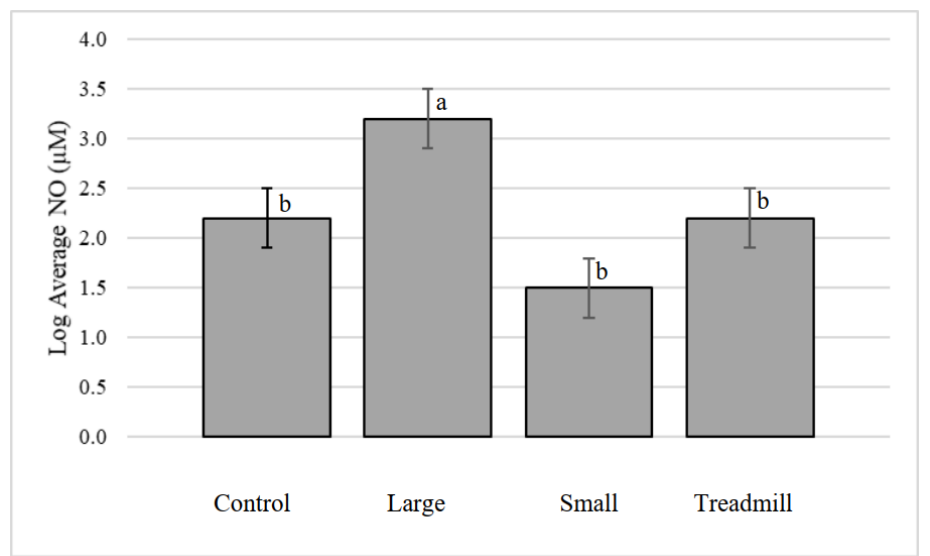
Figure 4. Log transformed average nitric oxide (NO) concentration in the lateral and medial fetlock joints by treatment . a, b Treatments that lack common superscripts differ ( p = 0.0005).